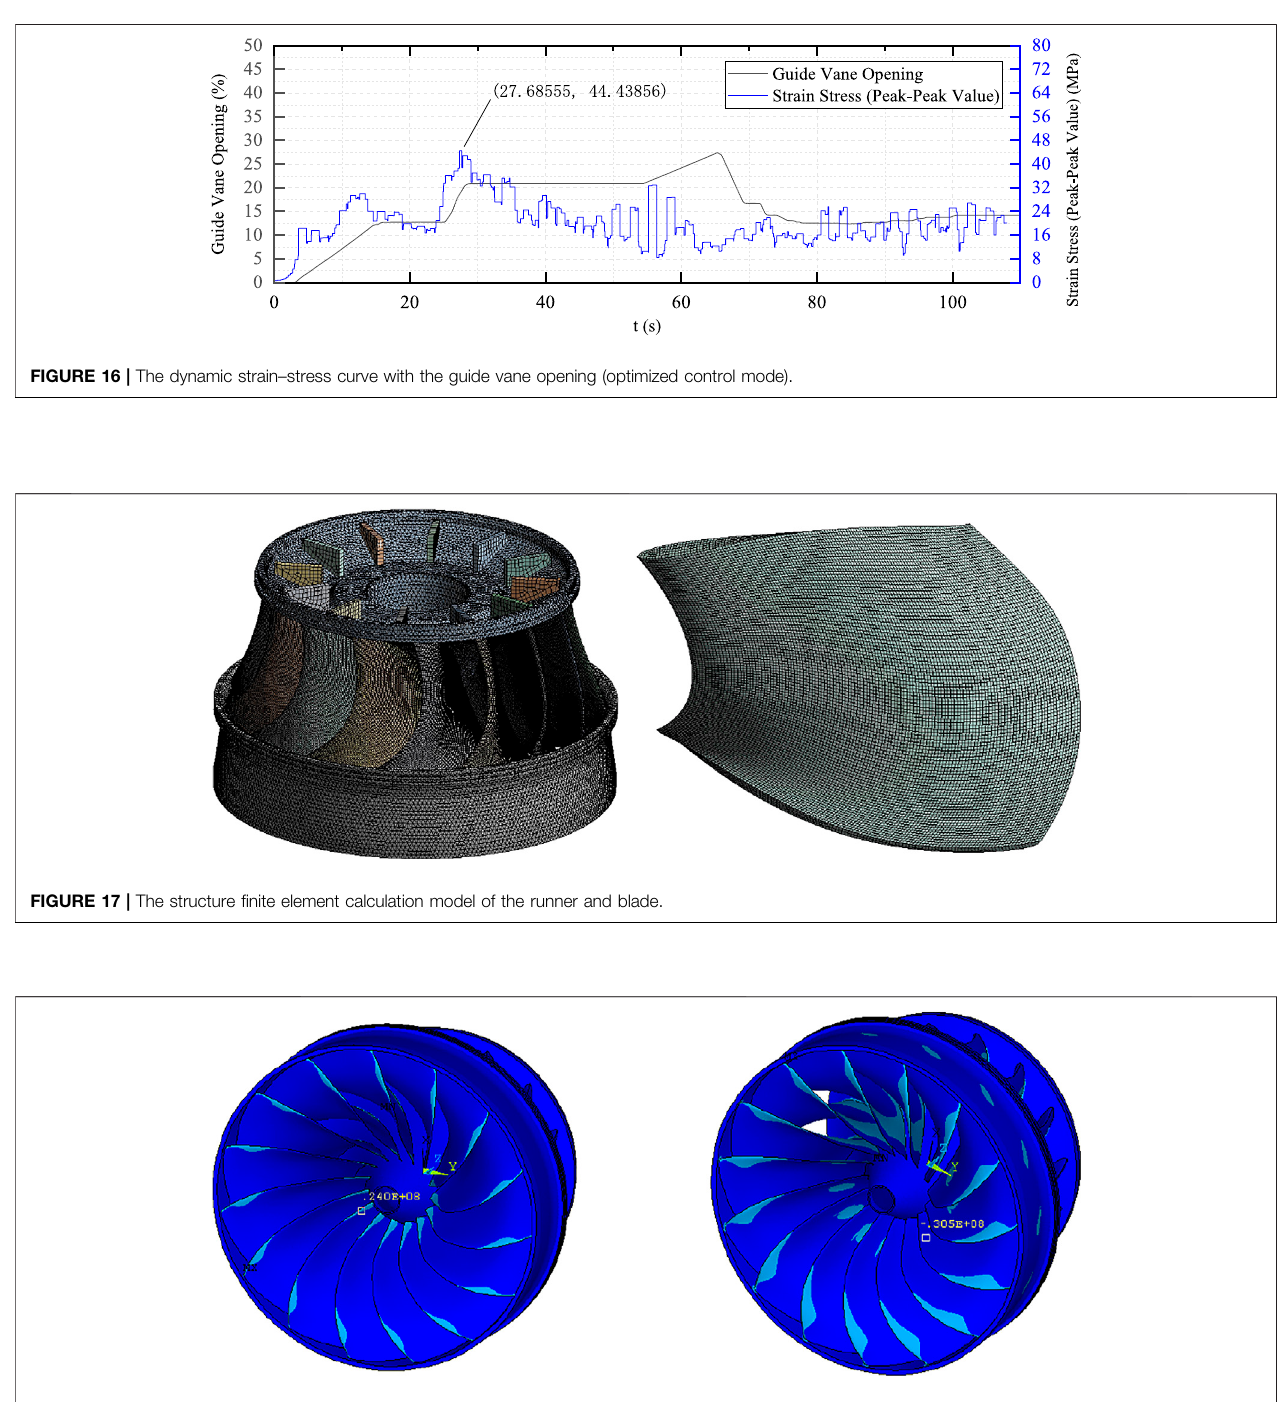
FIGURE 18 | The stress cloud diagram for the runner and blade (single-stage